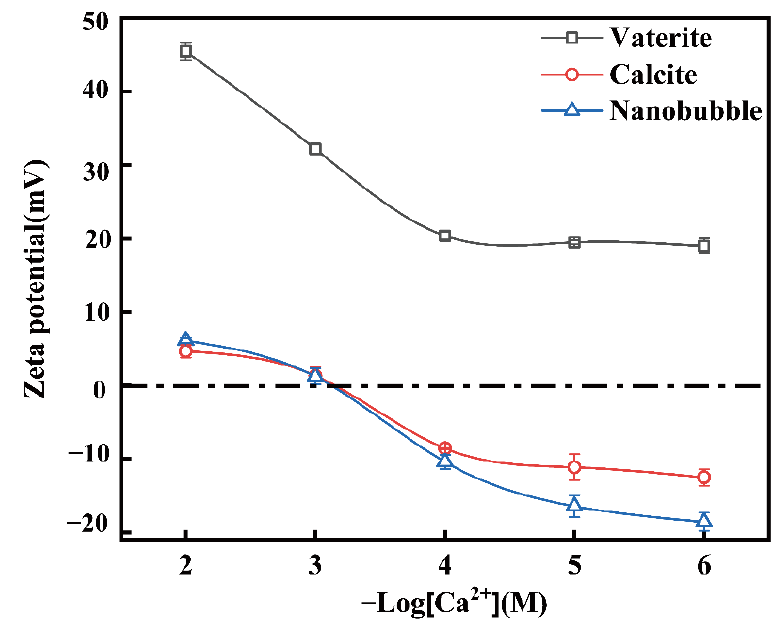
Figure 10. Zeta potential of air nanobubble, calcite, and vaterite in a 0.05 M of NaCl aqueous solution containing various concentrations of Ca 2+ at pH = 10.